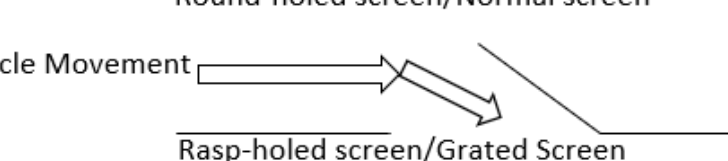
Figure 8. Comparison of particle movement between a normal screen (round shaped screen) and grated screen.